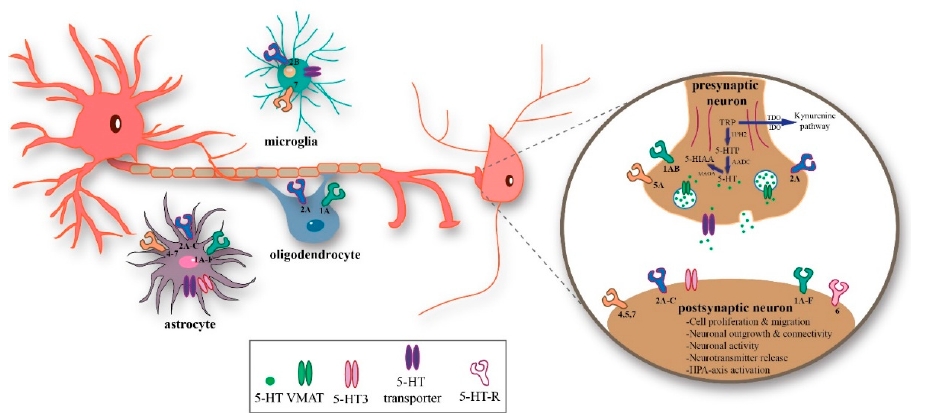
Figure 1. An integrated view of 5-HT signaling within the brain. 5-HT in the brain is synthesized from tryptophan via the enzymes Tph2 and AADC. 5-HT is transported via VMAT into synaptic vesicles. Exocytosis of these vesicles releases 5-HT into the synaptic cleft. Here, it can bind to 5-HT receptors localized on pre- and postsynaptic neurons and / or on glial cells (microglia, astrocytes, and oligodendrocytes). 5-HT signaling can be terminated by the reuptake of 5-HT via the 5-HT transporter. 5-HT is again transported into synaptic vesicles or converted to 5-HIAA via the enzyme MAOA. Within neurons, microglia, and astrocytes, tryptophan can be converted into kynurenine via the enzymes IDO and TDO. 5-HIAA: 5-hydroxyindole amino acid; 5-HT: serotonin; AADC: aromatic L-amino acid decarboxylase; IDO: indoleamine 2,3-dioxygenase; MAOA: monoamine oxidase A; TDO: tryptophan 2,3-dioxygenase; TPH2: tryptophan hydroxylase 2; VMAT: vesicular monoamine